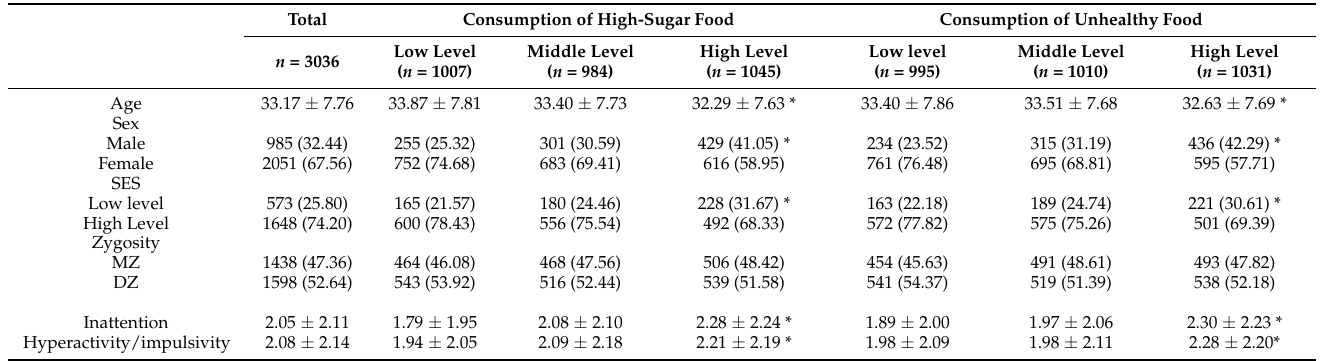
Table 1. Means and standard deviations (S.D.) for ADHD scales and intake frequency of high-sugar food and unhealthy, respectively, by age and sex group.